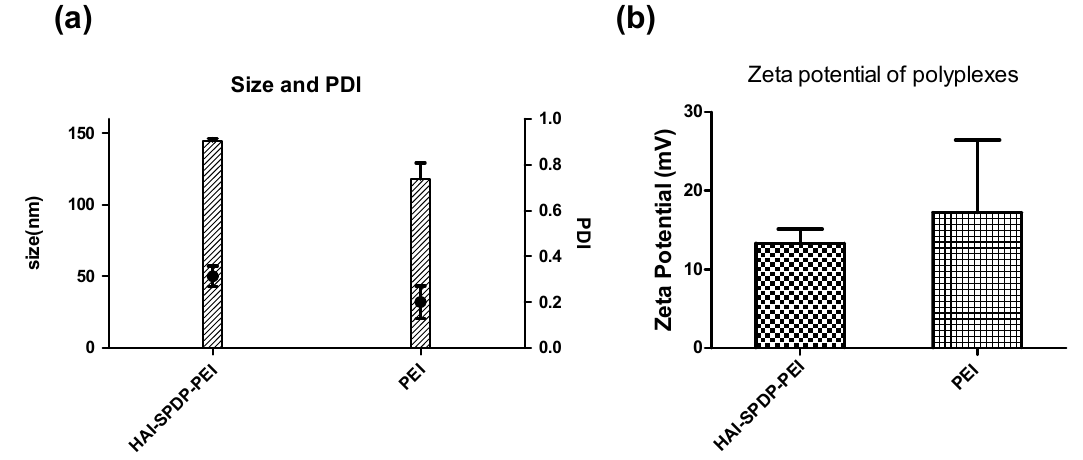
Figure 3. ( a ) Hydrodynamic diameters (left y -axis) and polydispersity index (PDI, right y -axis) and ( b ) zeta-potential of bPEI and HAI-SPDP-bPEI polyplexes containing 50 pmol of siRNA at N/P = 5. (Data points indicate mean ± SD, n = 3.)